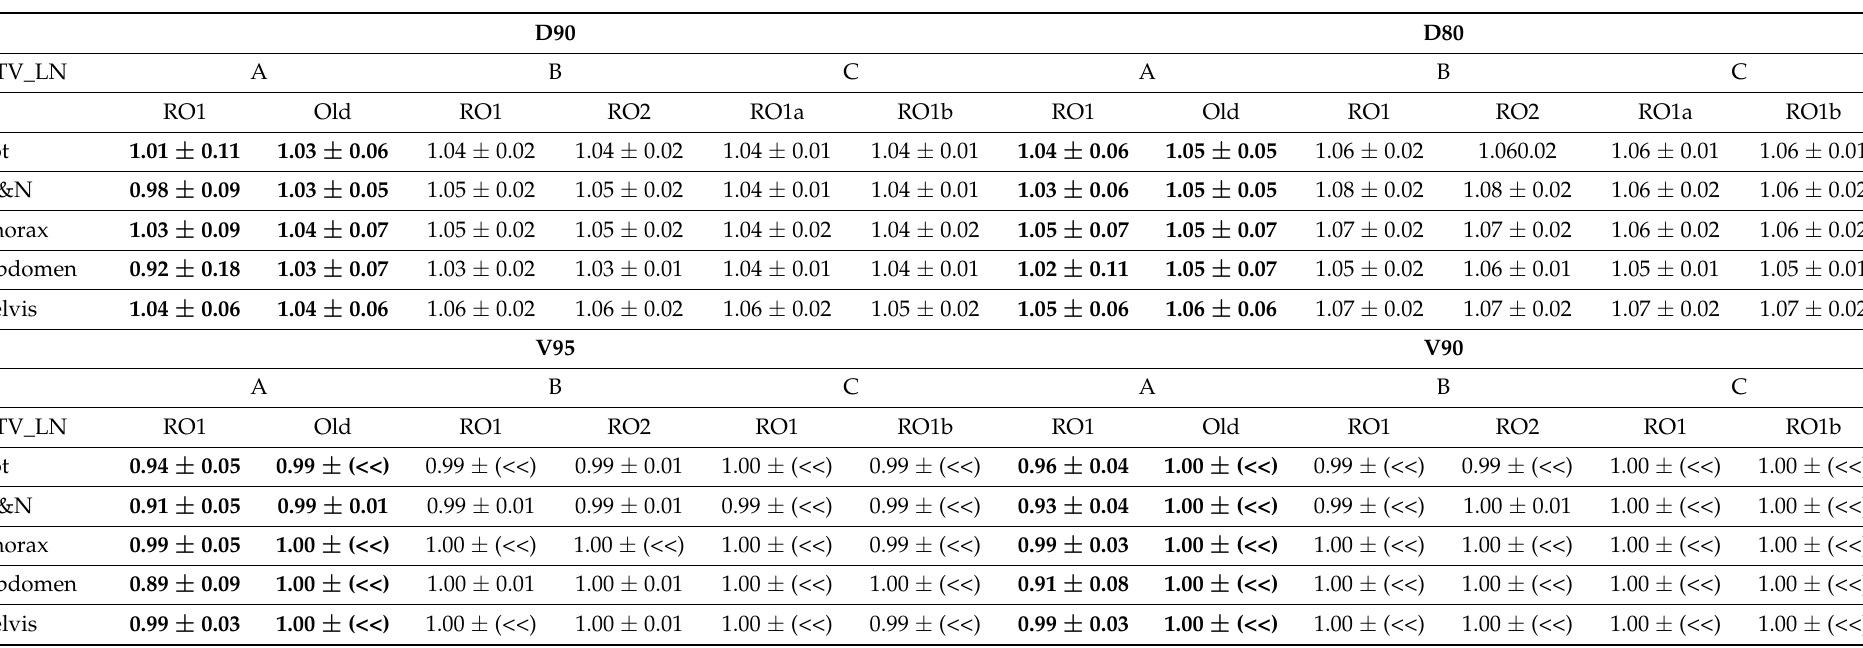
Table 5. Dosimetric parameter analysis for each comparison group: (A) before vs. after guidelines, (B) interobserver variability, (C) intraobserver variability. The values reported are normalized to the prescribed